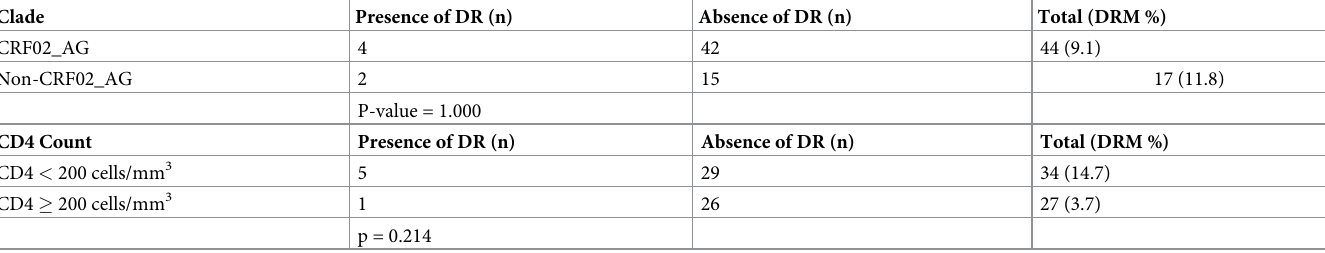
Table 2. Distribution of drug resistance by HIV-1 clade and WHO CD4 classification.